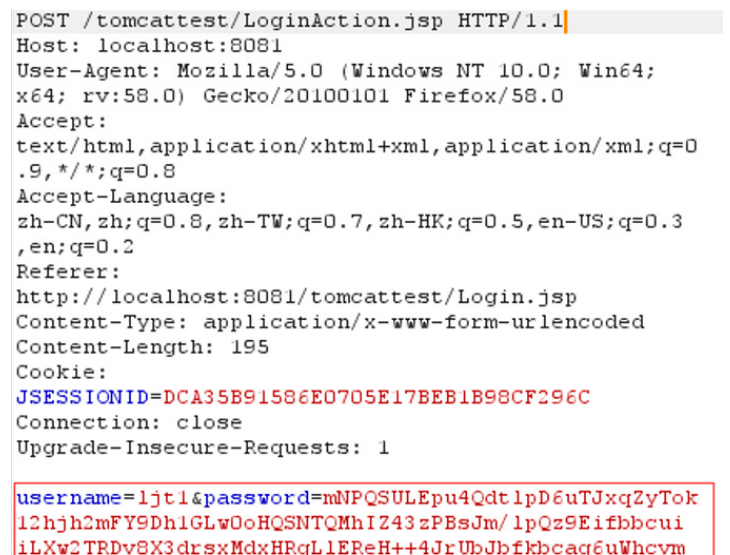
Figure 31. Dependencies of cryptographic functions in RSAAuth client-side implementations. Appl. Sci. 2018 , 8 , x FOR PEER